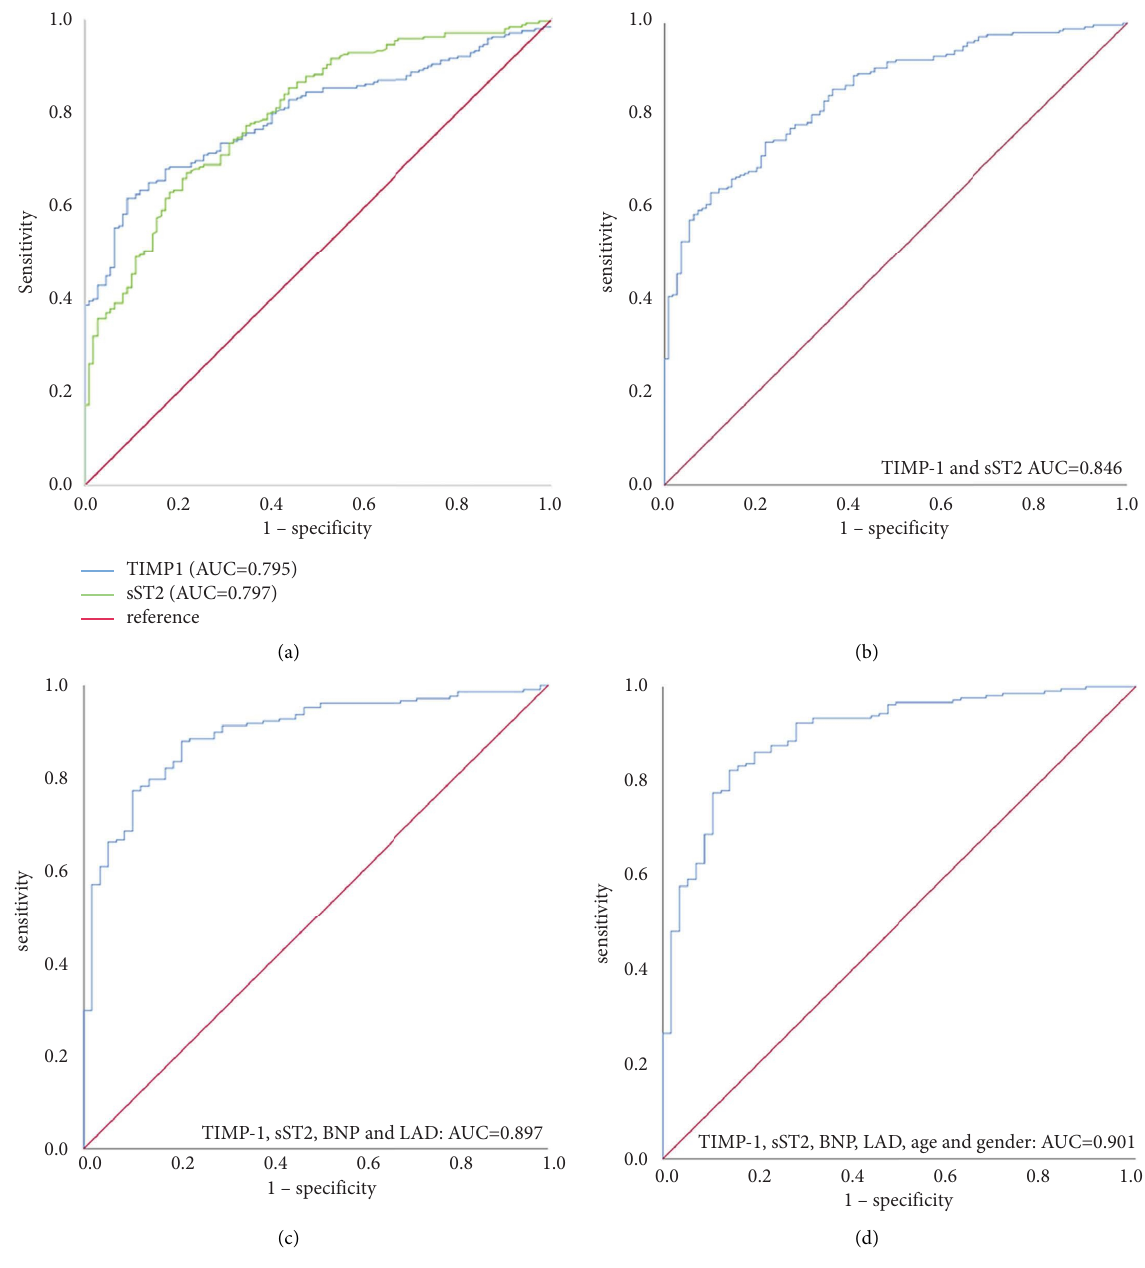
Figure 4: A receiver operator characteristics curve analysis with diferent factors for assessing the progression of atrial fbrillation. (a) Tissue inhibitor of matrix metalloproteinase (TIMP-1) and soluble suppression of tumorigenicity 2 protein (sST2) individually. (b) TIMP-1 and sST2 combined. (c) TIMP-1, sST2, brain natriuretic peptide (BNP), and left atrial diameter (LAD) combined. (d) TIMP-1, sST2, BNP, LAD, age, and gender